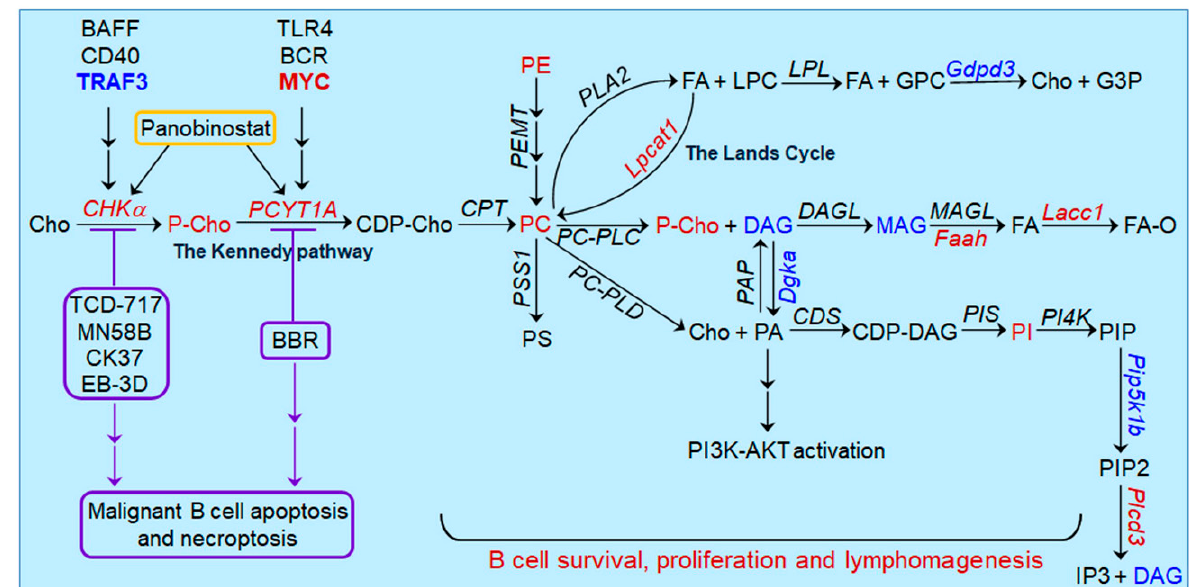
Figure 2. Oncogenic pathways upstream and downstream of aberrant choline metabolism discovered in B cell malignancies. Pathway schematics depict the anabolic and catabolic pathways of PC. Enzymes are denoted in Italic font in the schematics. Metabolites, lipids and metabolic enzymes that are dysregulated in malignant B cells are indicated in red (for up-regulated) or blue (for down-regulated). Available evidence shows that overexpression of two key enzymes, CHK α and PCYT1A (also known as CCT), are overexpressed in malignant B cells and mediate increased PC biosynthesis. Loss of the tumor suppressor TRAF3 and elevation of the oncoprotein MYC are common oncogenic alterations that induce the overexpression of CHK α and PCYT1A in B cell malignancies, respectively. In addition, BAFF or CD40 stimulation induces the expression of CHK α , while TLR4 or BCR engagement induces the expression of PCYT1A in normal B lymphocytes. Expression of both CHK α and PCYT1A is also induced by the KDAC inhibitor panobinostat in DLBCL cells. Several catabolic products of PC such as DAG, PA, LPC and arachidonic acid (a fatty acid) can act as lipid second messengers to induce the activation of downstream signaling pathways. Specifically, PA has been shown to activate the PI3K-AKT pathway in DLBCL. Therapeutic targeting of CHK α by pharmacological inhibitors (TCD-717, MN58B, CK37 or EB-3D) or PCYT1A by the lipid-lowering alkaloid BBR induces apoptosis and necroptosis of malignant B cells both in vitro and in vivo, indicating a causal role for CHK α or PCYT1A overexpression in B lymphomagenesis.